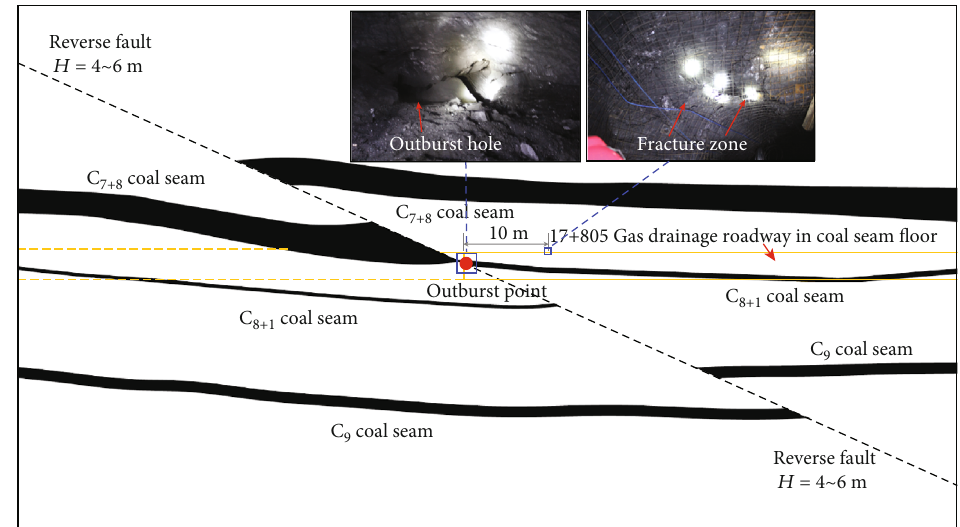
Figure 4: Field investigation features of outburst in the Bailongshan Coal Mine